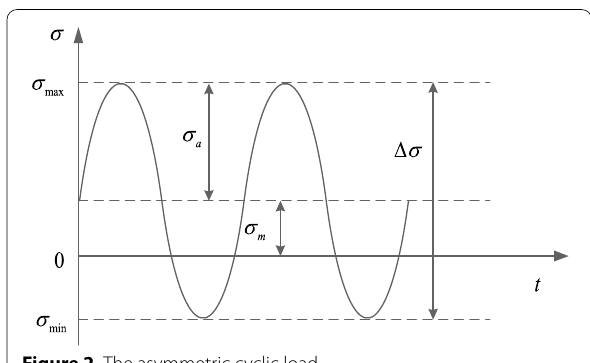
Figure 2 The asymmetric cyclic